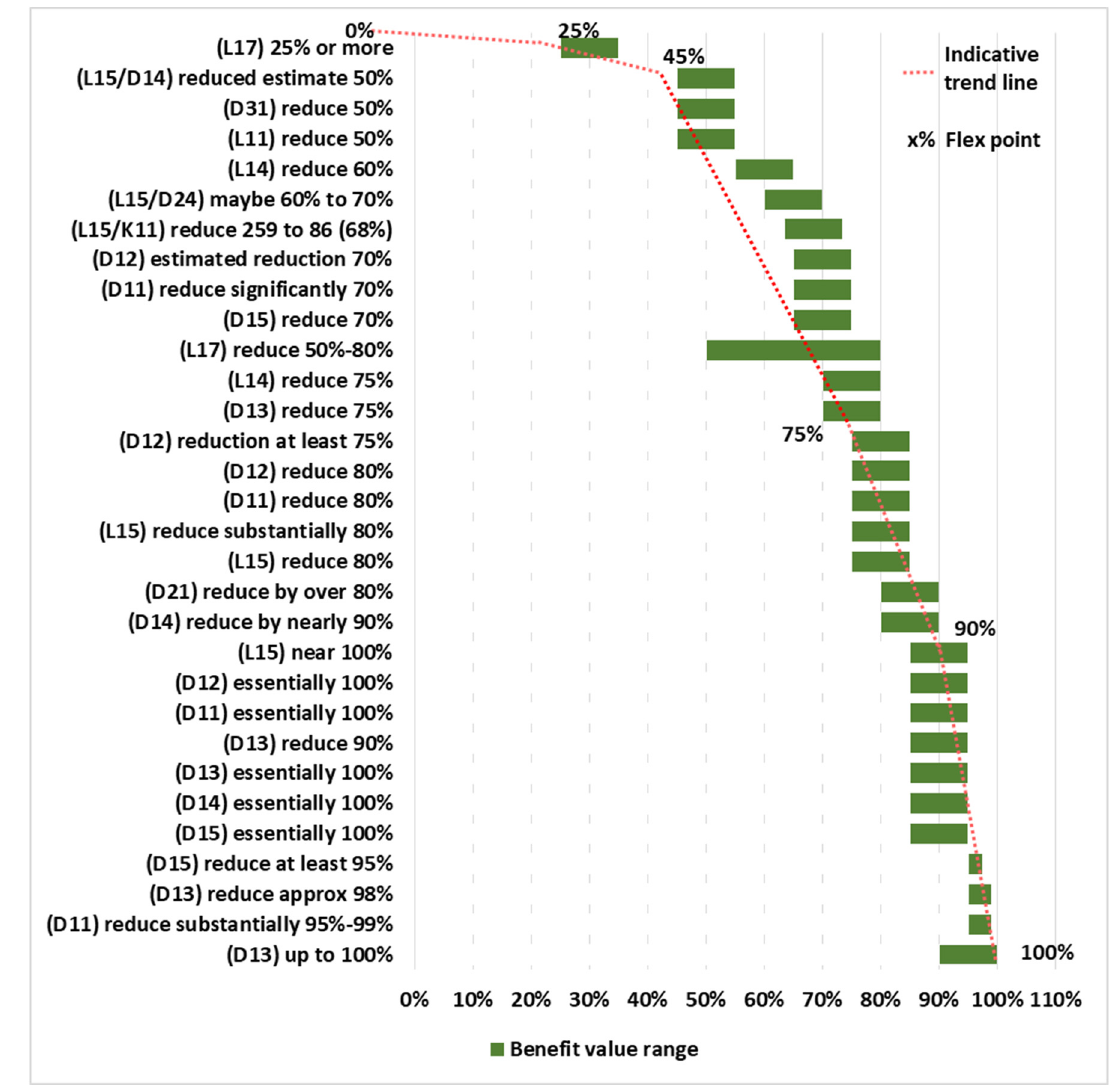
Figure 6. Charges and operational costs benefits: the phrase used to describe %-benefit value (y-axis) in expert assessments, shown as high–low ranges (rectangles), against the expected %-benefit value i.e., savings (x-axis). Same annotations as in Figure 5.